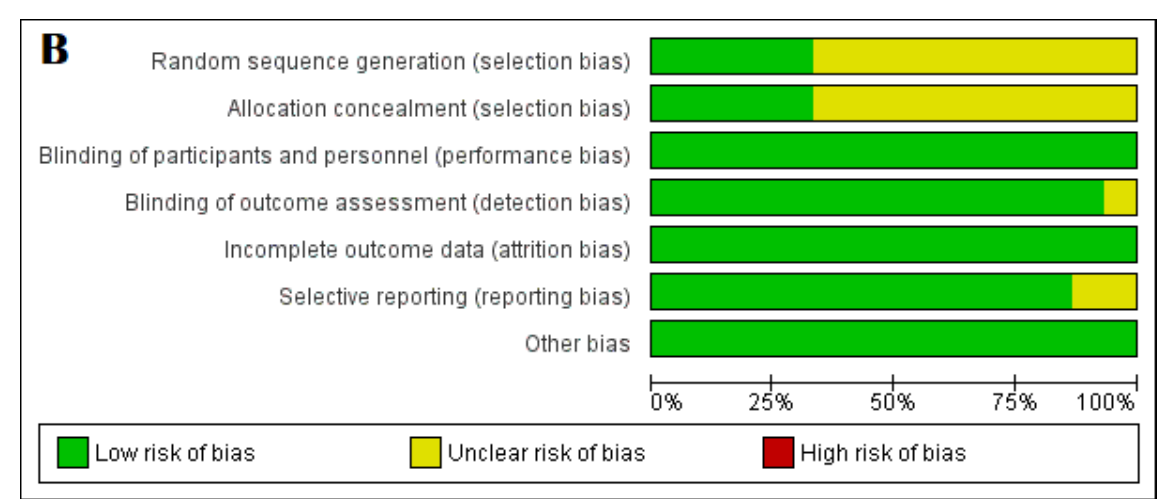
Figure 2. ( A ) Risk of Bias assessment; ( B ) Risk of Bias summary.